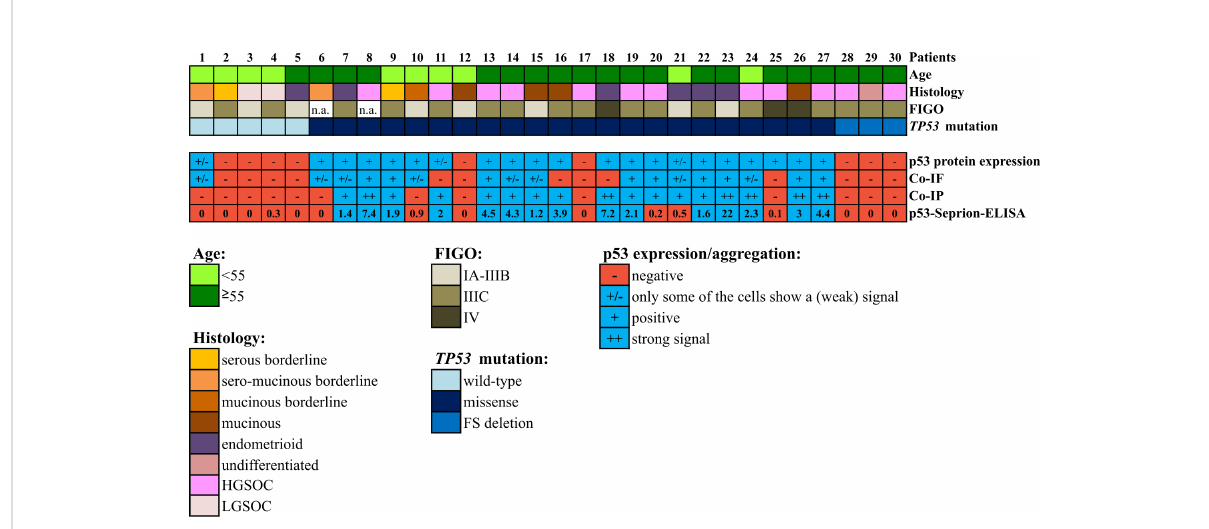
FIGURE 4 Comparison of the three techniques for the detection of p53 aggregates in 30 ovarian cancer tissue samples. Co-IF and co-IP were performed using the anti-p53 and the anti-oligomer A11 antibodies. “ FIGO ” , International Federation of Gynecology and Obstetrics; “ Co-IF ” , Immuno fl uorescence co-localization assay. “ Co-IP ” , Co-immunoprecipitation; “ HGSOC ” , high-grade serous ovarian cancer; “ LGSOC ” , low- grade serous ovarian cancer. “ n.a. ” ; not